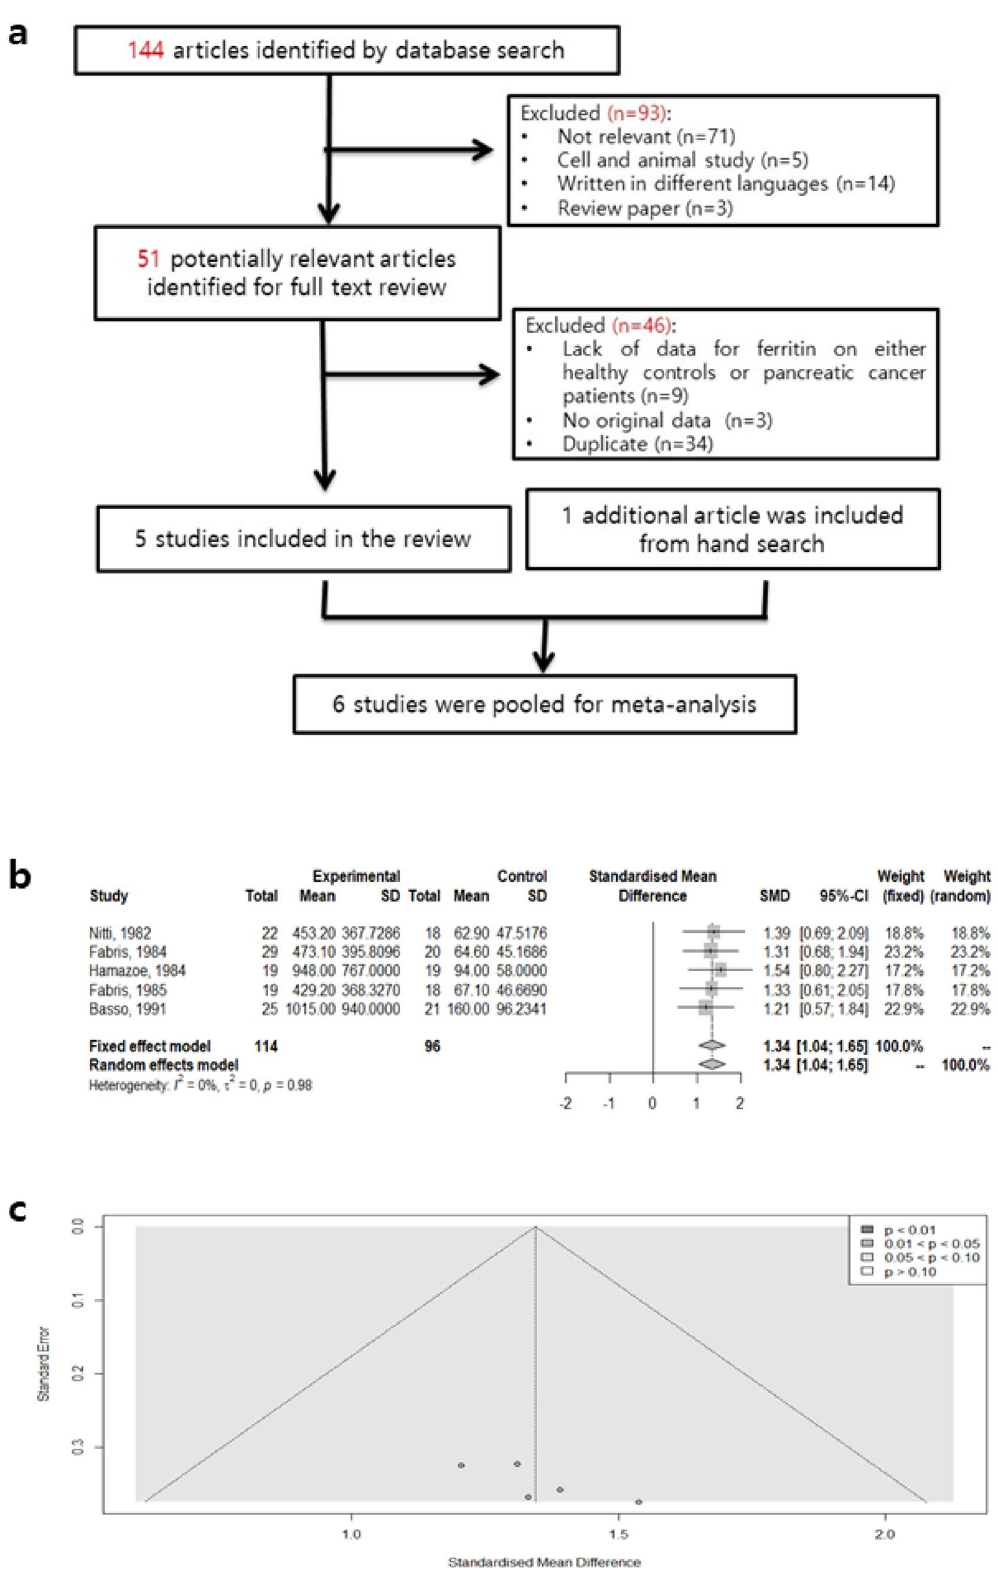
Figure 1. Meta-analysis of SF and pancreatic cancer risks. ( a ) Flow diagram of screened and included papers for meta-analysis. ( b ) Forest plot of studies in serum ferritin for subjects with pancreatic cancer (Experimental; n = 114) versus healthy controls (Control; n = 96). Standard mean difference (SMD) and 95% confidence intervals (CI) were calculated on the basis of both fixed-effect and random-effect models. ( c ) Funnel plot of studies in serum ferritin for subjects with pancreatic cancer versus healthy